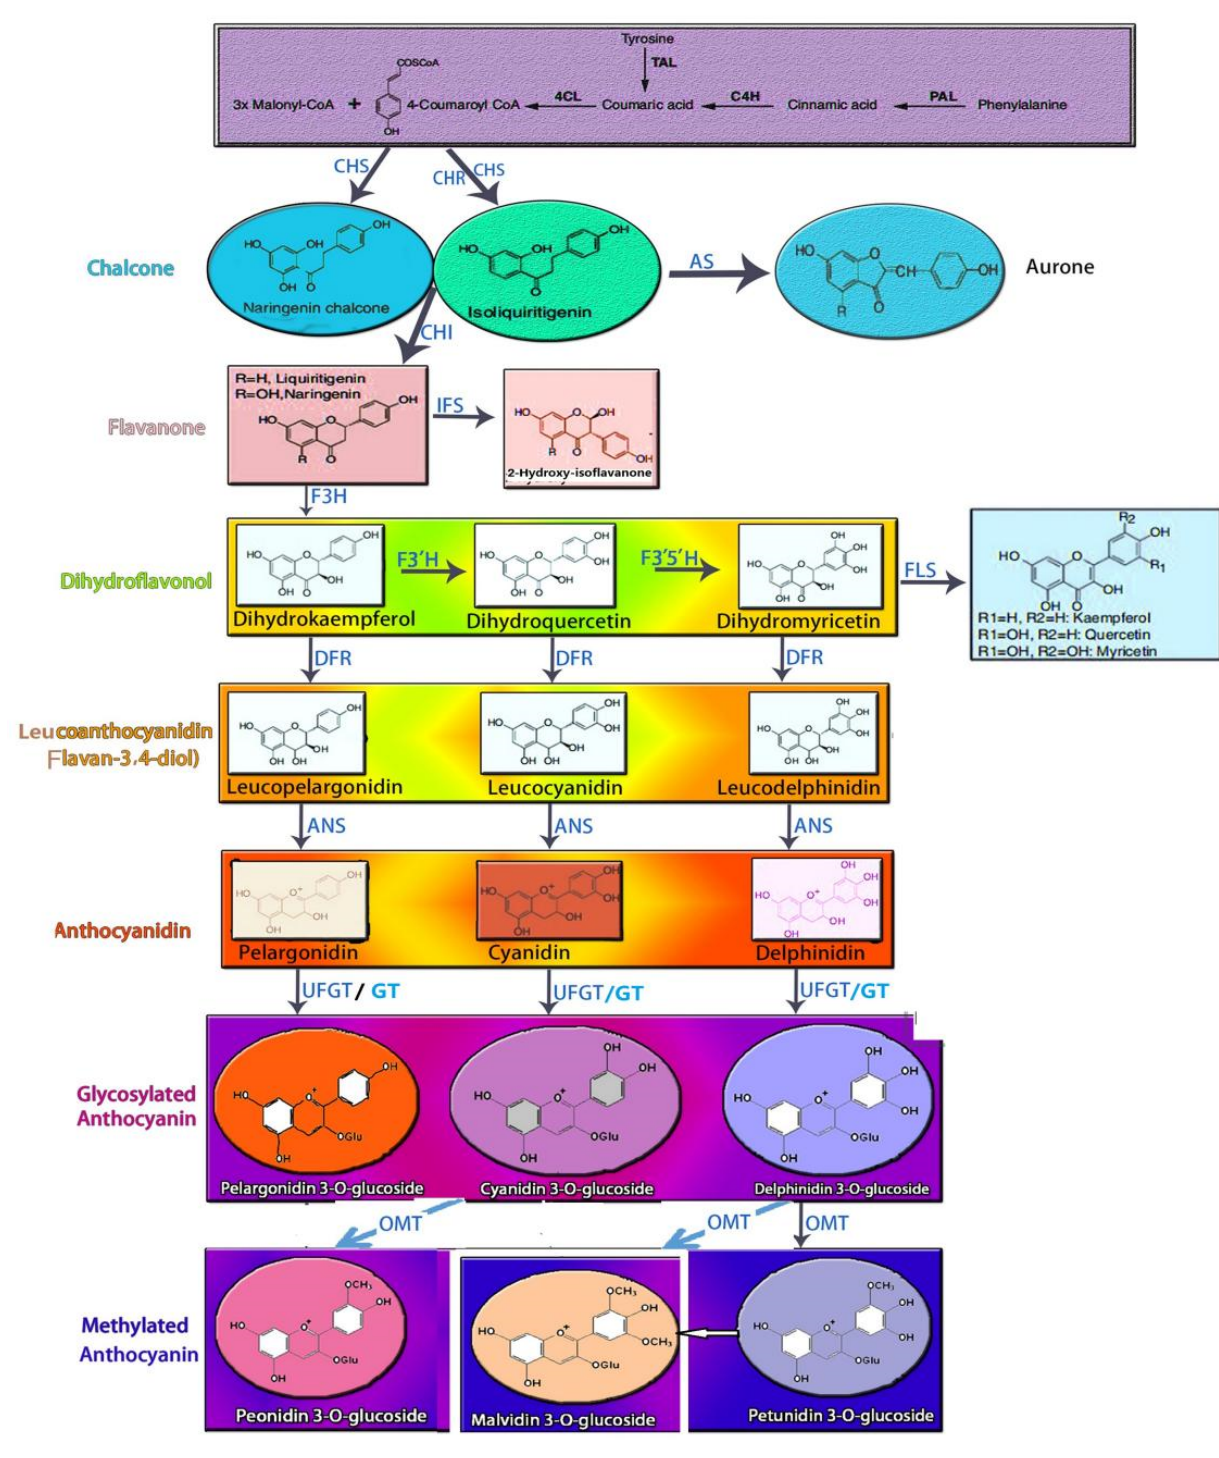
Figure 2. Anthocyanin biosynthesis pathways in rice. Table 4. Anthocyanin biosynthesis-related genes in